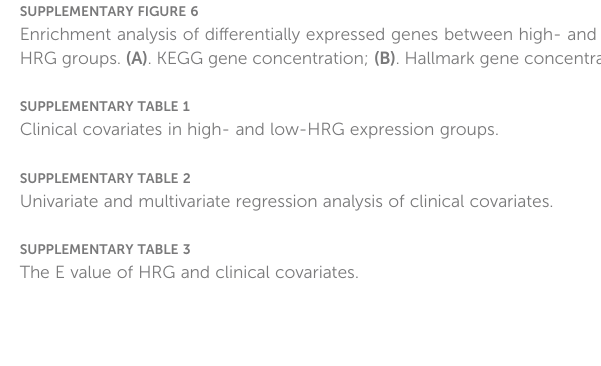
− Papillary subtype (D) correlated with poorer survival results. OS outcome did not correlate with gender (E) and histologic_stage (F) . SUPPLEMENTARY FIGURE 4 Landmark analysis plotted KM curves at different periods. For 12, 24, 36, 48, and 60 months after diagnosis as Landmark, higher HRG was not associated with improved patient survival at an early stage (A – E) . SUPPLEMENTARY FIGURE 5 Survival Analysis with HRG expression in IMvigor210 cohort. (A) . Kaplan-Meier curve showed that there was a difference in OS between high and low HRG expression groups (P =0.083); (B) . With 16 months after diagnosis as Landmark, higher HRG was associated with improved patient survival at an early stage (P=0.044); (C) . With 20 months after diagnosis as Landmark, higher HRG was associated with improved patient survival at an early stage (P=0.049). SUPPLEMENTARY FIGURE 6 Enrichment analysis of differentially expressed genes between high- and low-